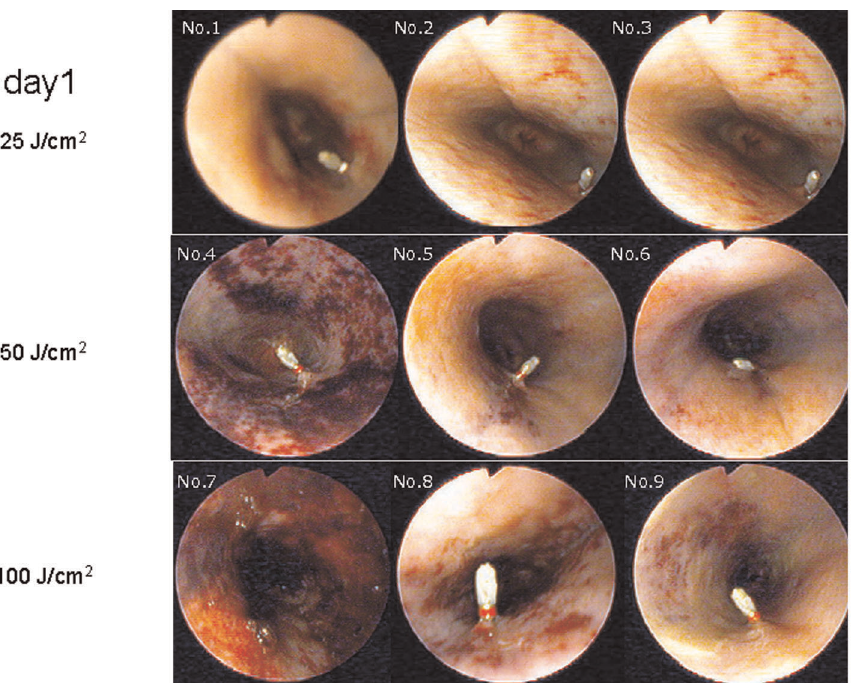
Figure 2. Endoscopic findings in the esophagus on postirradiation day 1. In all dogs except one in the 25 J/cm 2 group, the mucosa at the site of irradiation (the area at 9 o’clock) showed reddish color changes on day 1 (A–C). Redness and ischemic color changes were observed at the site of irradiation in all dogs in the 50 J/cm 2 and 100 J/cm 2 groups (D–I). doi:10.1371/journal.pone.0038308.g002 PLoS ONE |